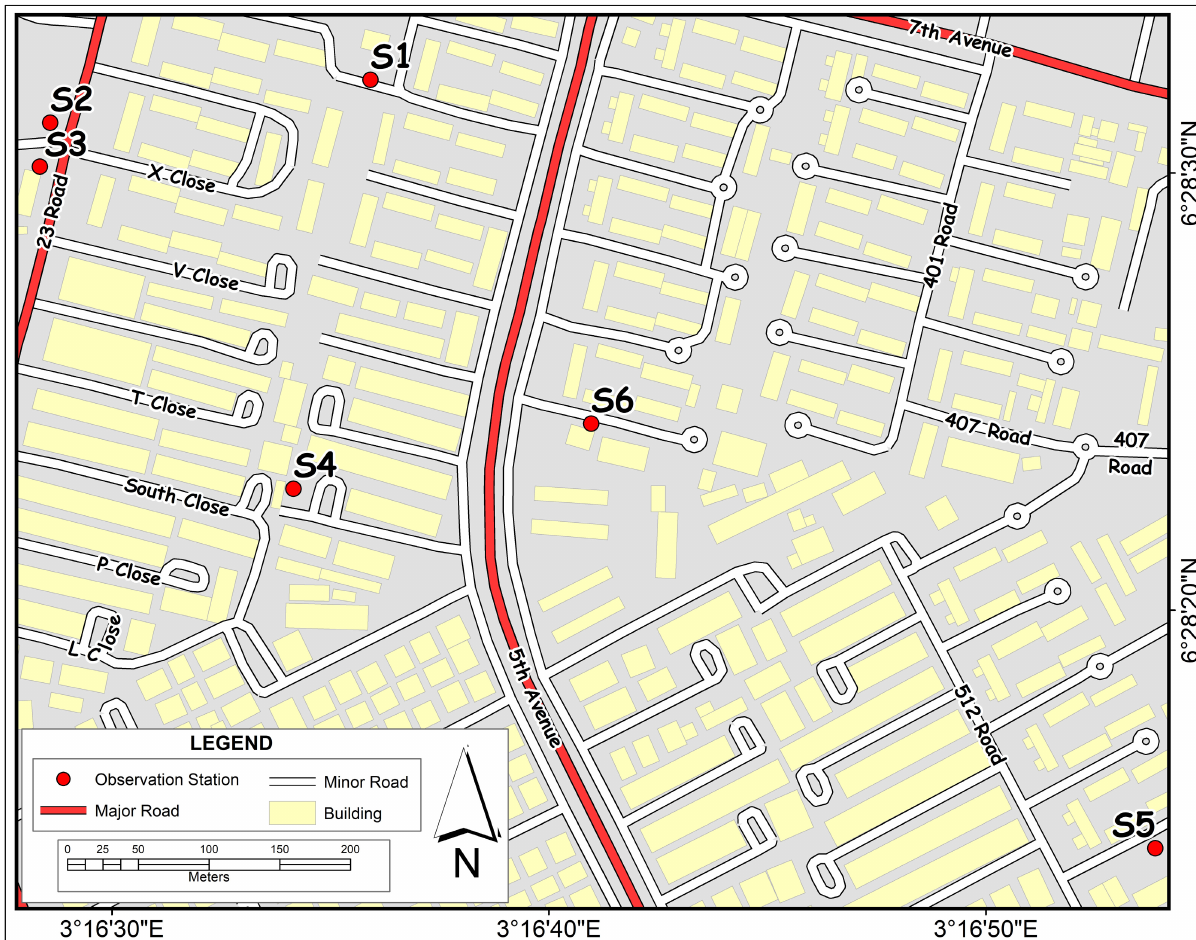
Figure 2: Map showing the spatial distribution of the observation stations